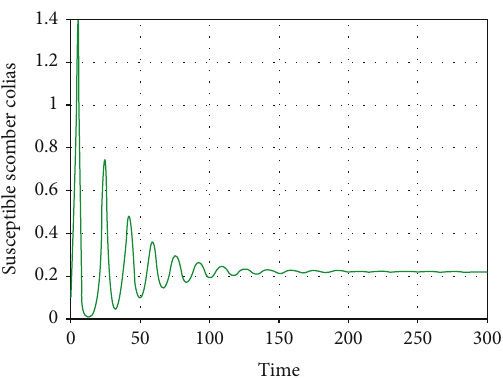
Figure 3: Dynamical behavior of the susceptible Scomber colias.